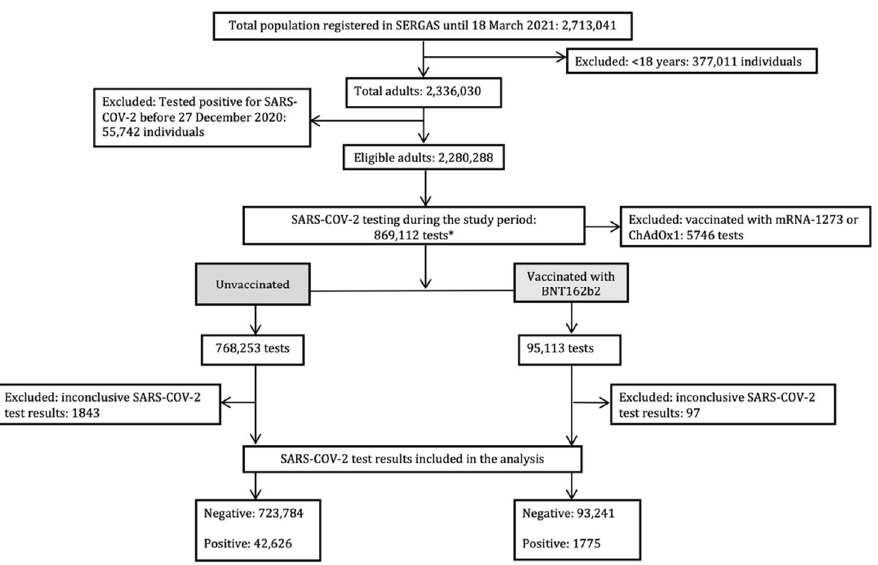
Figure 1. Flow diagram of participants’ selection and SARS-CoV-2 test inclusion in the study.